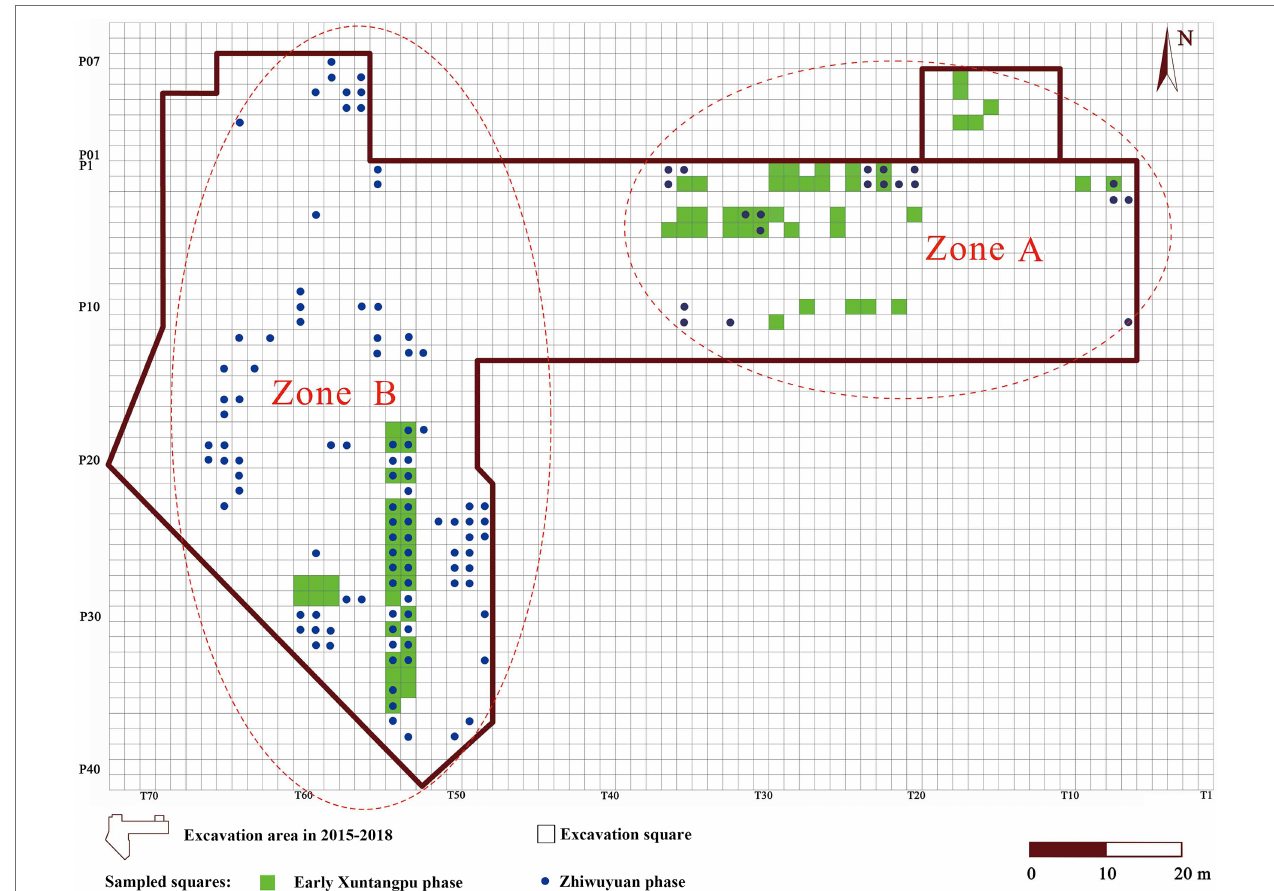
FIGURE 2 | Layout of the excavation area and the distribution of sampled squares of the Zhiwuyuan site in